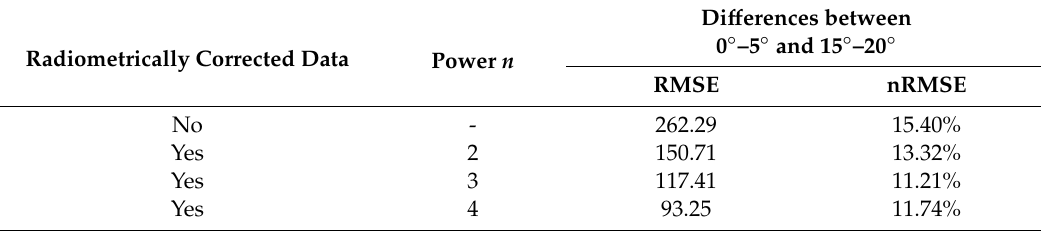
Table 2. RWE di ff erences between the di ff erent scan angle intervals (0 ◦ –5 ◦ and 15 ◦ –20 ◦ ). RMSE: root-mean-square error; nRMSE: normalized RMSE.